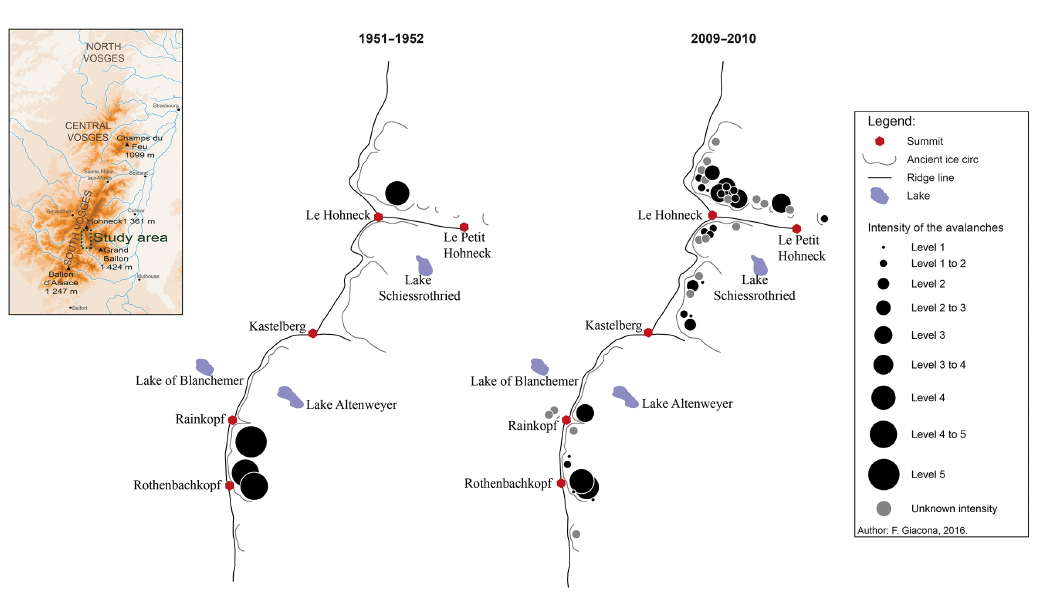
Figure 8. Location and intensity level of the avalanches occurring in the Hohneck–Rothenbachkopf sector during the winters of 1951/1952 and 2009/2010, respectively, obtained from the geo-chronology developed in this